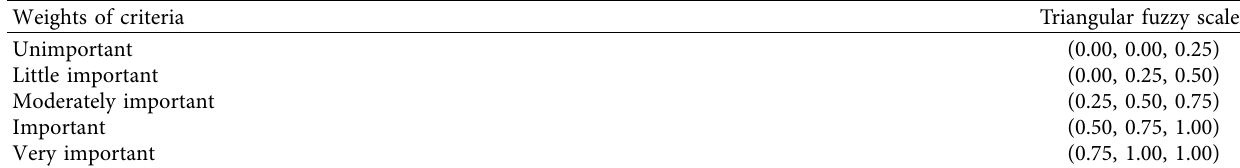
Table 4: Descriptions of factors.